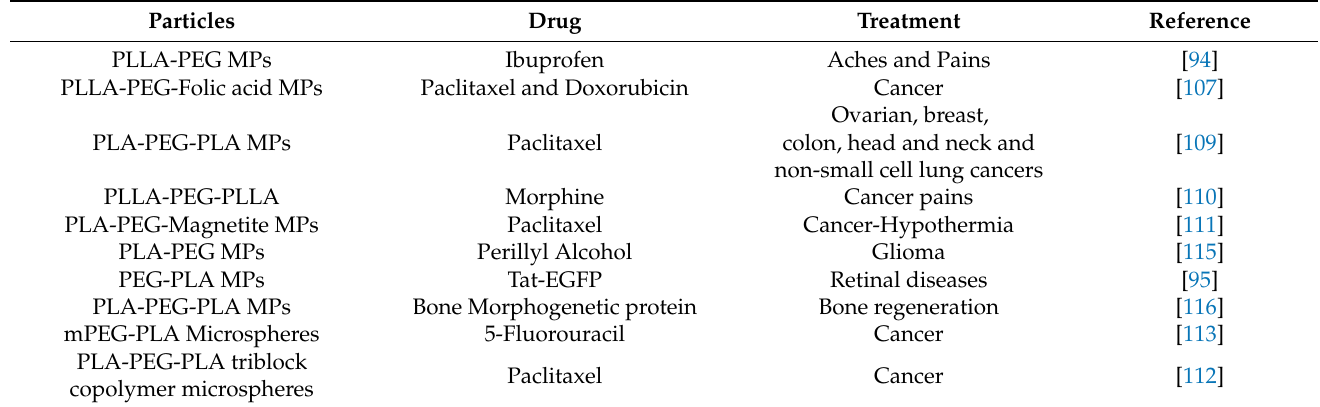
Table 3. Microparticles from PLA-PEG copolymers for controlled drug